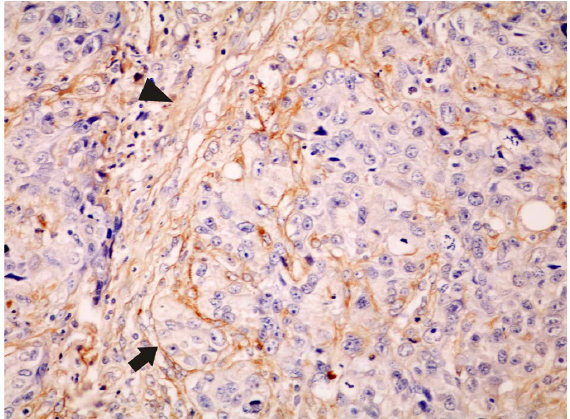
Figure 1. Immunoexpression of fibronectin in SCCTo throughout peritumoral basement membrane (arrow) and tumor stroma (arrowhead) (Labelled Streptavidin Biotin (LSAB) method, original magnification ×400).